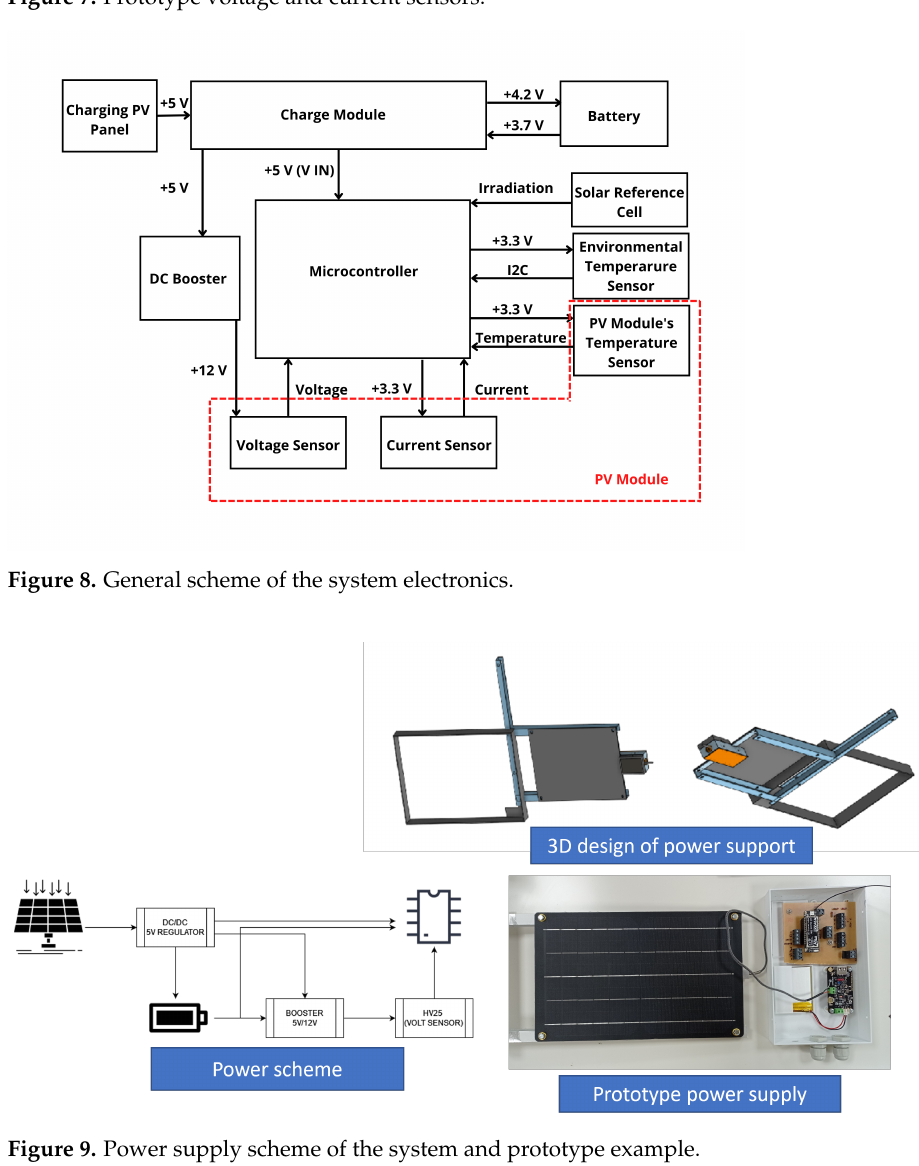
Figure 7. Prototype voltage and current sensors.